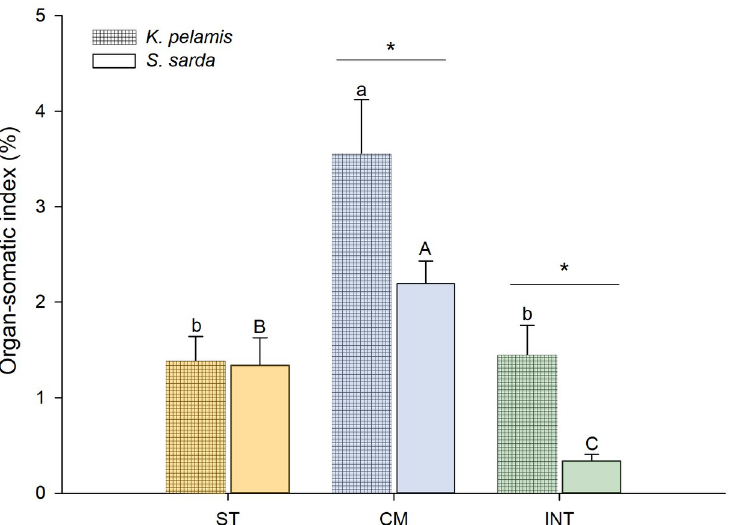
Fig 1. Digestive organ-somatic indices. Organ-somatic indices (OSI) for stomach (ST, orange), caecal mass (CM, blue) and intestine (INT, green) of Katsuwonus pelamis (gridded bars) and Sarda sarda (smooth bars). Data are presented as mean ± SD (n = 10). Different lowercase letters (a,b) represent statistical differences between digestive organs of S . sarda , while different capital letters (A, B, C) represent statistical differences between digestive organs of K . pelamis (P < 0.05). Asterisks represent statistical differences between species (P < 0.05). Absence of asterisk indicates no statistical difference between species (P > 0.05).